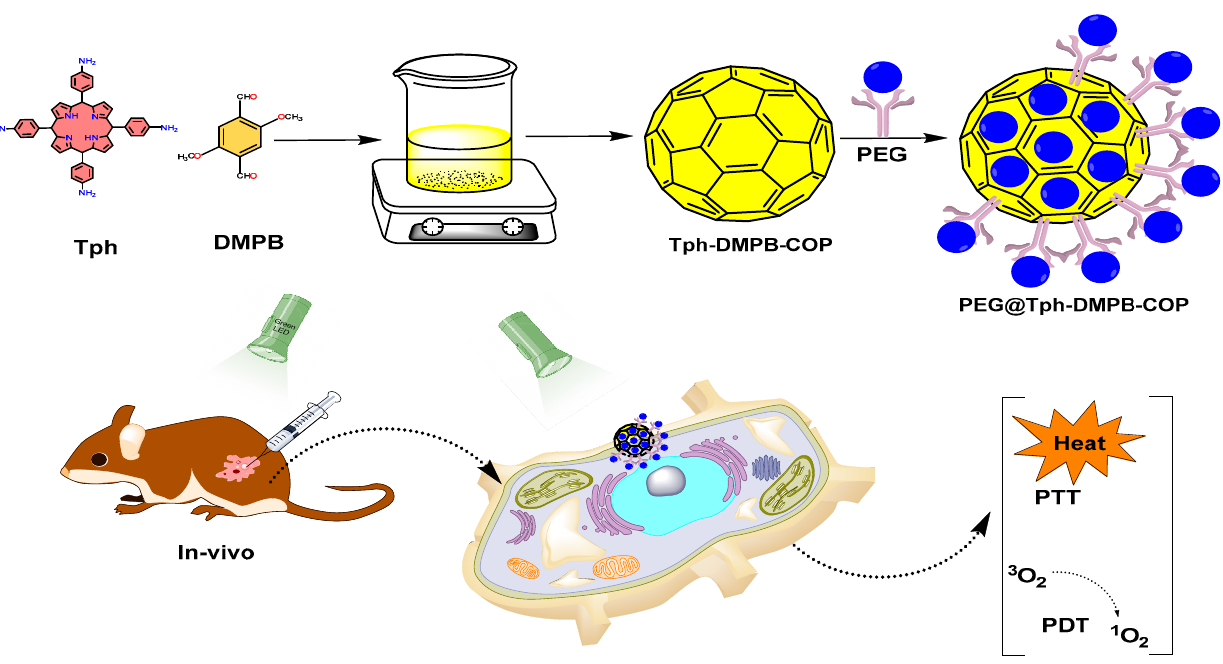
Figure 10. Schematic representation of a PEG-protected COF synthesized from Tph and DMTP, and its PDT and PTT applications [48].